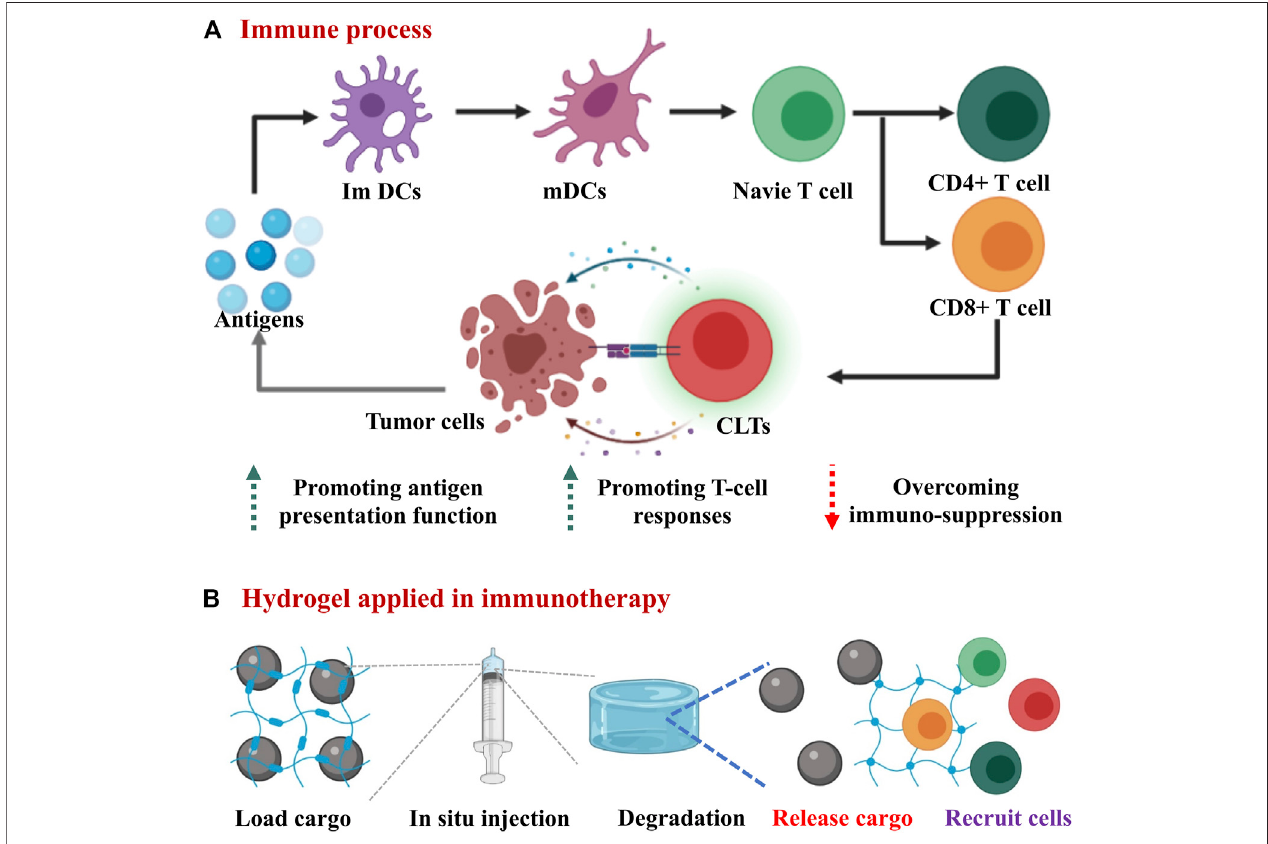
FIGURE 1 | Overview scheme of hydrogels applied in cancer immunotherapy. (A) The schematic diagram of the immune response in the body: antigens are processed by immature dendritic cells (ImDCs), then mature dendritic cells (mDCs) presented antigens to T cells. CD8 + T cells further differentiate into cytotoxic T lymphocytes (CTLs) to directly kill tumor cells. (B) hydrogels applied in immunotherapy: the hydrogel carrying various cargos is injected into the tumor site and then undergoes degradation, thereby releasing drugs and recruting immune cells to tumor site.